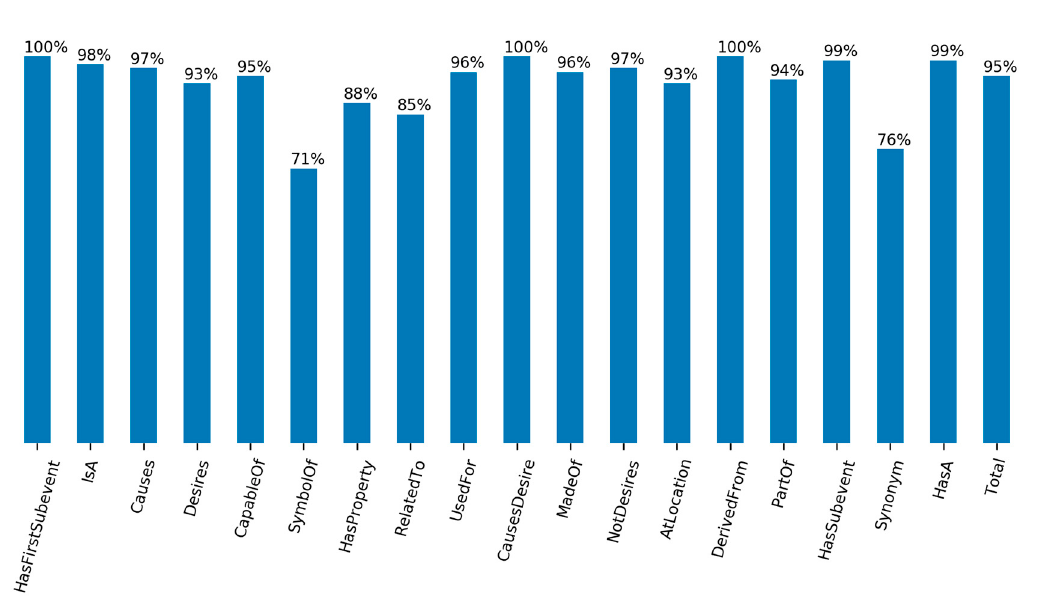
Figure 3. Accuracy of bilingual phrase semantic similarity model for each relation type.